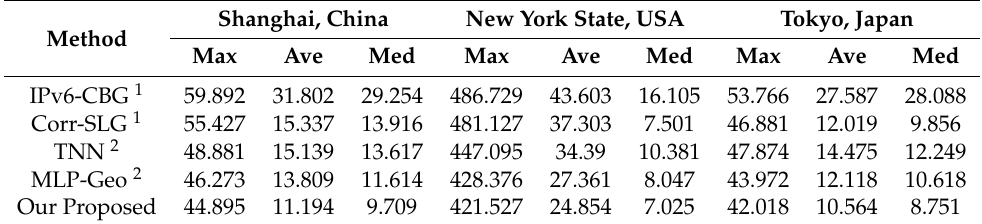
Table 3. Performance (kilometers) comparison of baselines and SubvectorS_Geo.